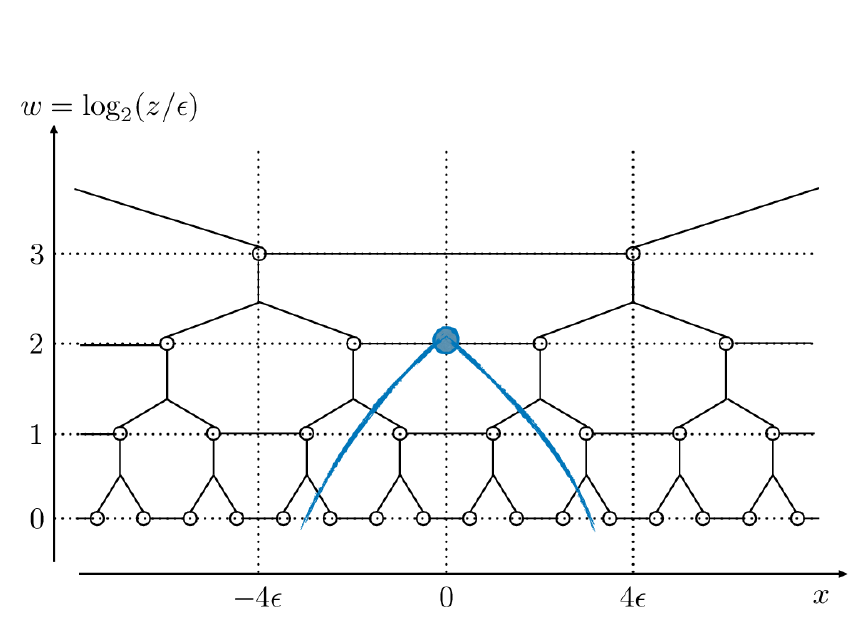
Figure 24 . A tensor network description of local operator quench at t = 4 (cid:15) . The blue dot is the large modi(cid:12)cation of tensor dual to the falling particle. The blue curves describe the image of shock wave deformation of tensors. The parameters of tensors are expected to be modi(cid:12)ed, and tensors close to the blue curve are expected to accept the strongest